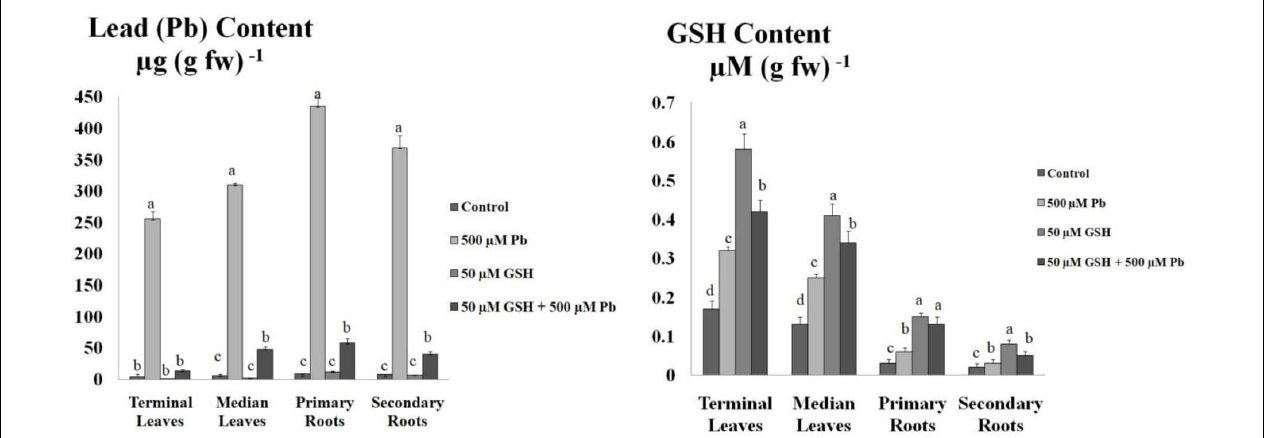
FIGURE 2 | Lead (Pb) and GSH concentration in upland cotton leaves and roots. Upland cotton seedlings exposed to Pb (500 µ M) and GSH (50 µ M) alone and in combination showing Pb uptake and GSH concentration in terminal leaves and median leaves, and primary roots and secondary roots. Error bars on columns show standard deviation among the values. Chart data are means of three independent biological replications, analyzed through one way analysis of variance (ANOVA) and significant difference determined by Duncan’s multiple range test at 0.05% probability level.